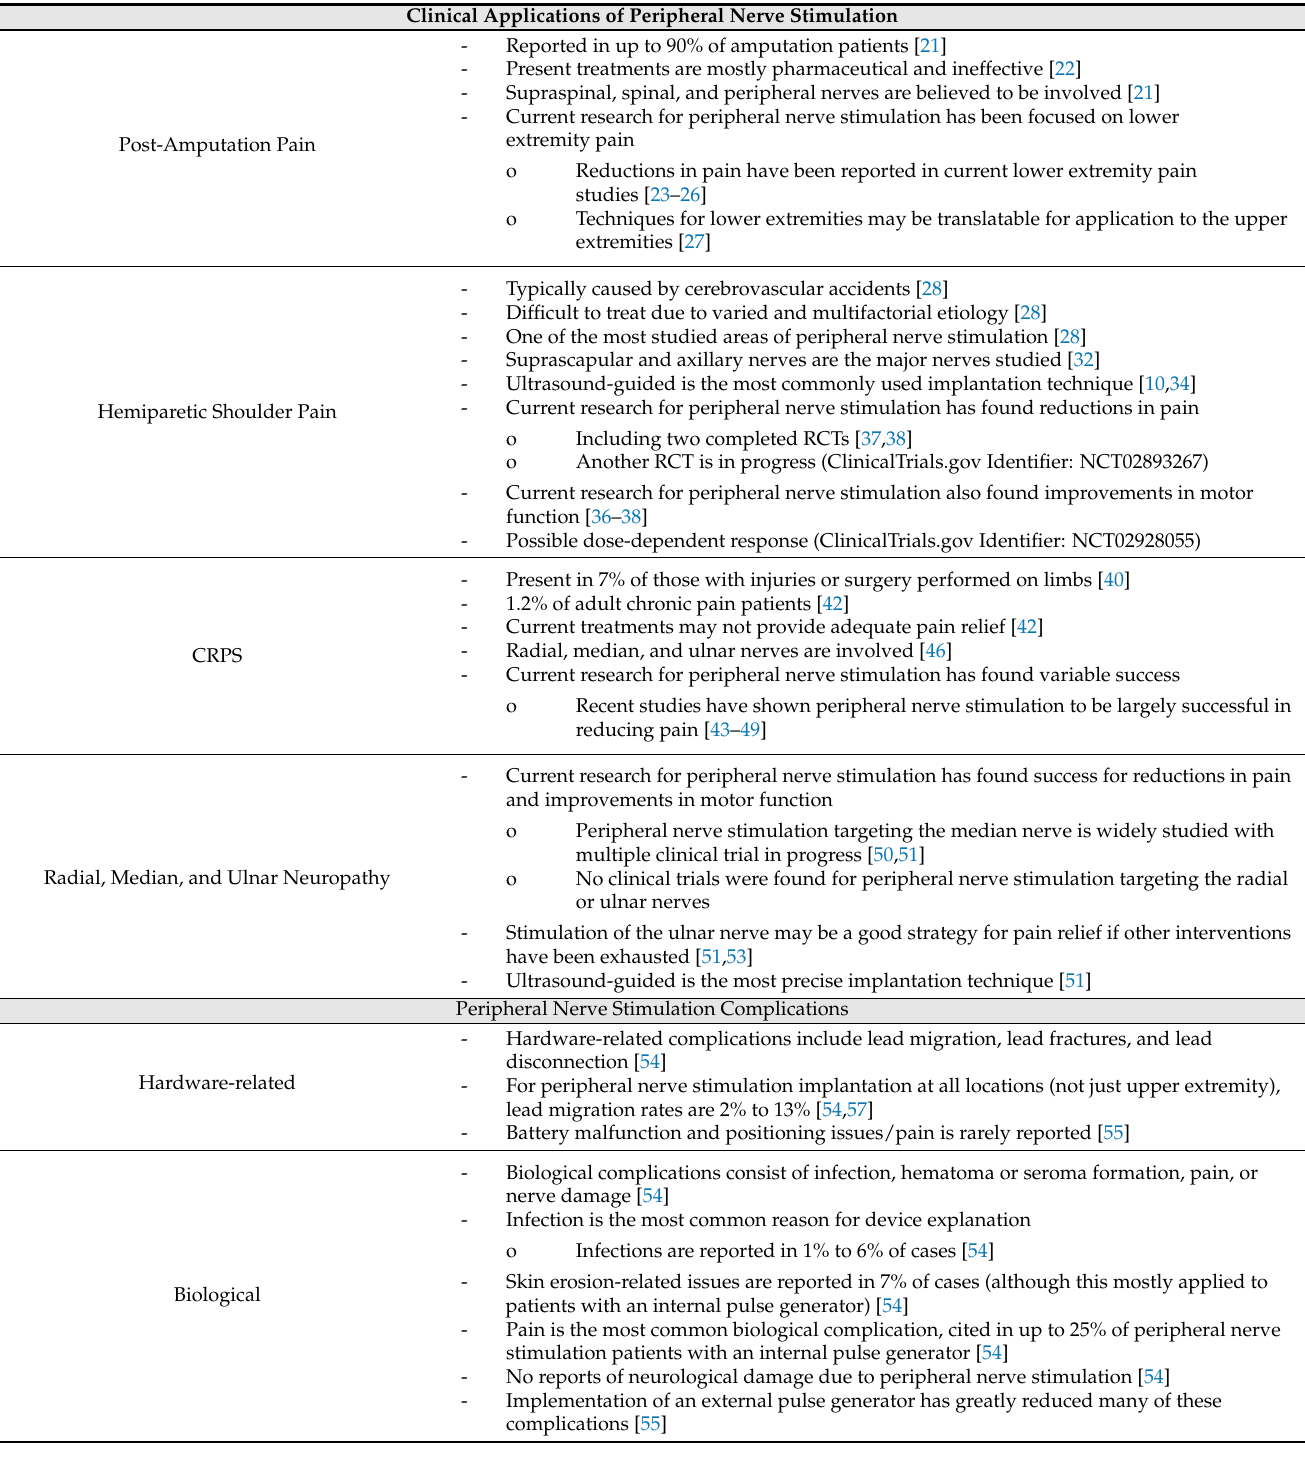
Table 1. Summary of clinical applications and